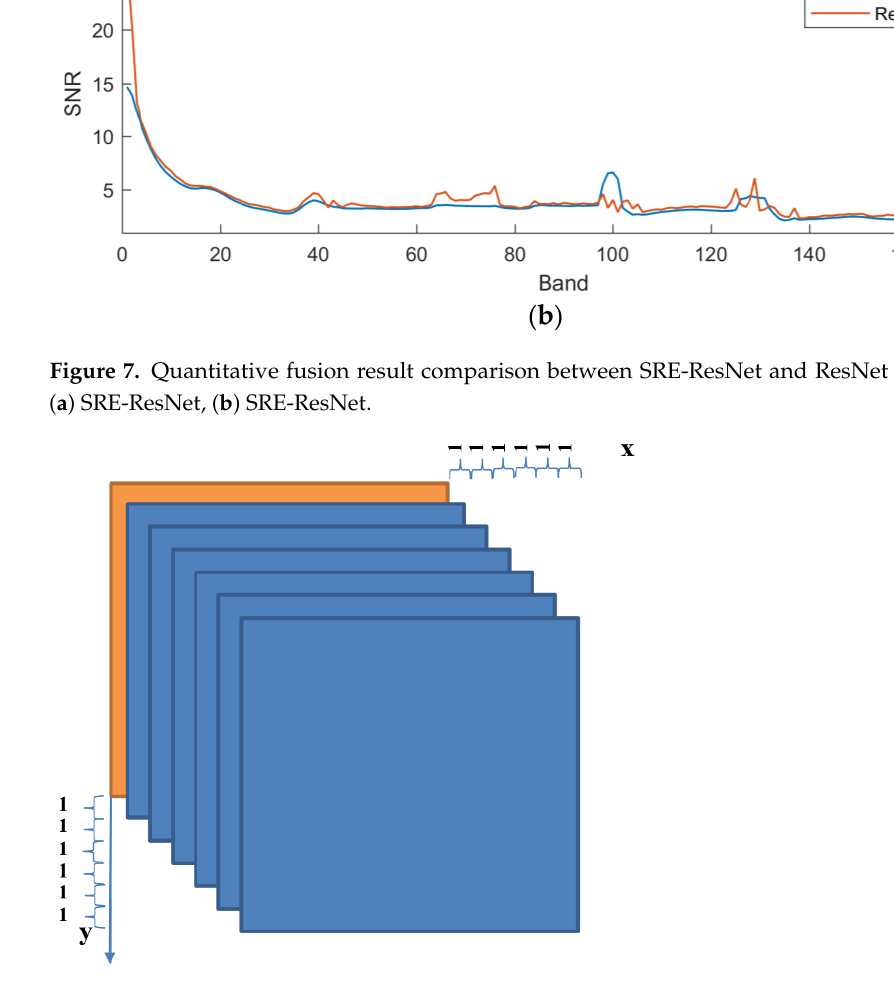
Figure 8. Simulation of registration errors between hyperspectral data and multispectral data.